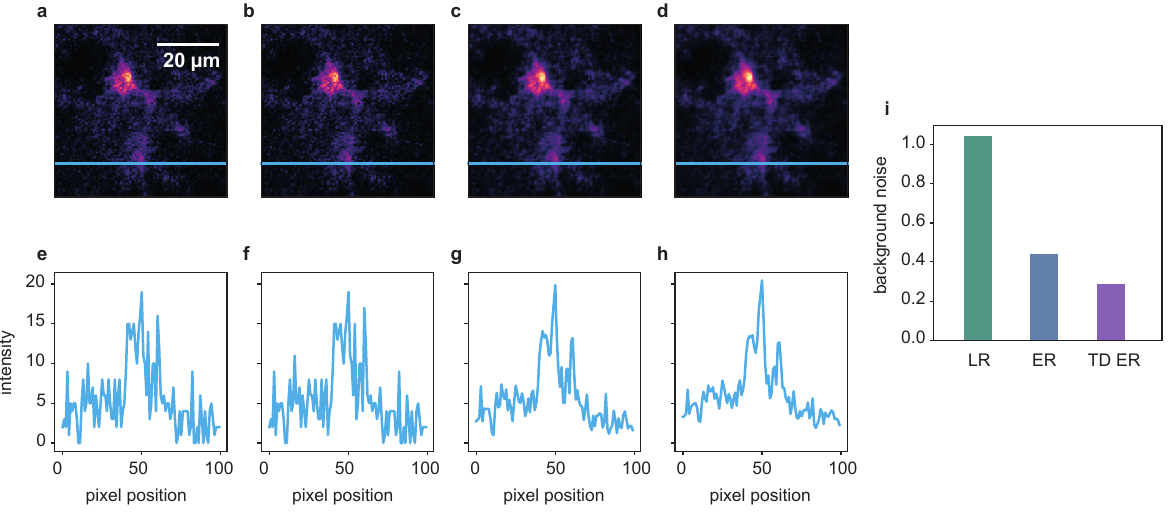
Figure 7. Deconvolution results for a jGCaMP7b-expressing astrocyte in a mouse brain slice. ( a ) Raw image, ( b ) LR result, ( c ) ER result and ( d ) TD ER result. Entropy parameters here are λ = 0.05 and ( λ = 0.05, λ T = 0.05) and ε = 0.001. Panels ( e – h ) show the intensity profile plotted along the blue line in the frames above. Panel ( i ) shows the amount of background noise remaining in the image after the application of the different deconvolution algorithms, normalized to the noise level of the original